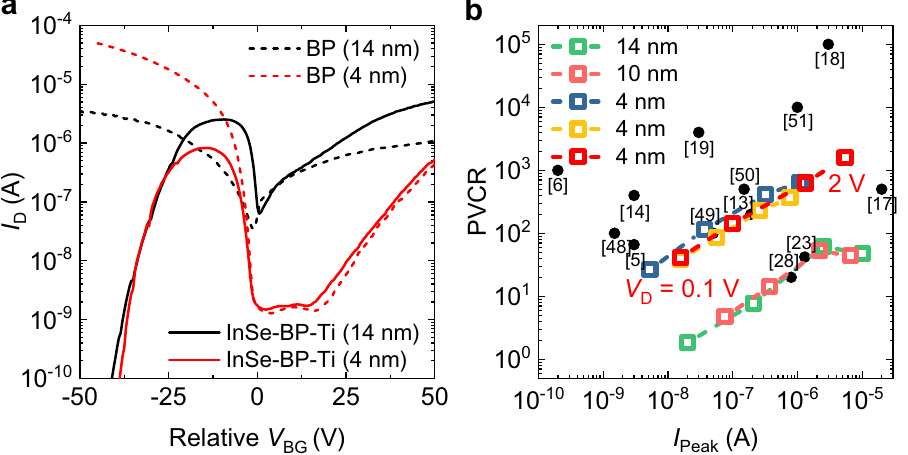
Figure 6. ( a ) I D versus V BG transfer characteristics of the InSe-BP-Ti devices (solid) and the BP (dashed) with different BP thicknesses, which are presented in parentheses. The V BG is shifted relative to the minimum current point of the BP for each device. ( b ) PVCR versus I Peak characteristics of our multiple InSe-BP-Ti devices with different BP thicknesses, accompanied by previously reported PVCR values of other 2D material–based NDT devices for